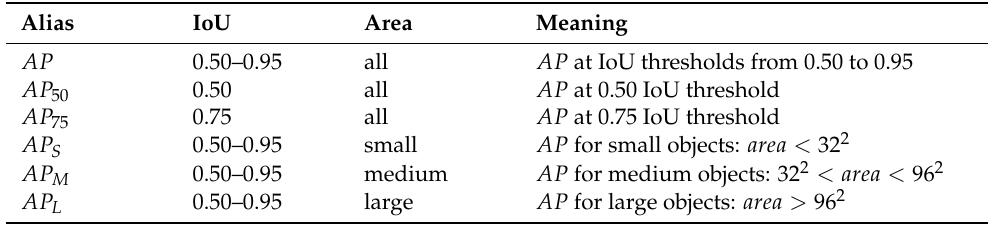
Table 1. Evaluation metrics.